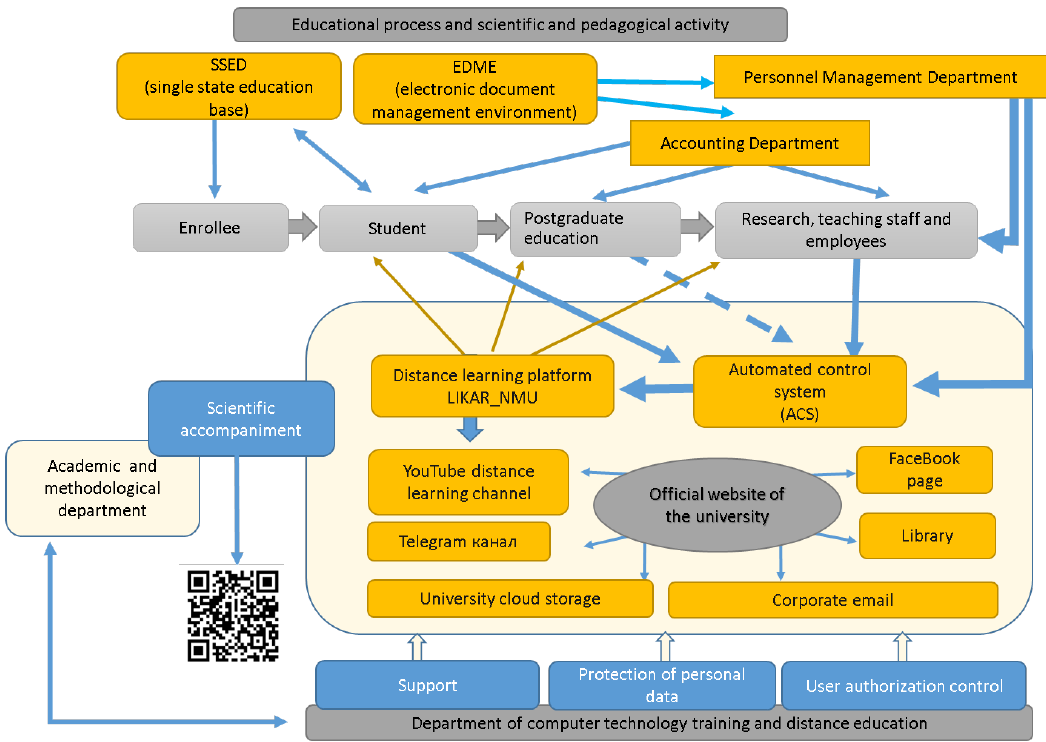
Figure 1: Model of information and educational environment of the Bogomolets National Medical University “NMU